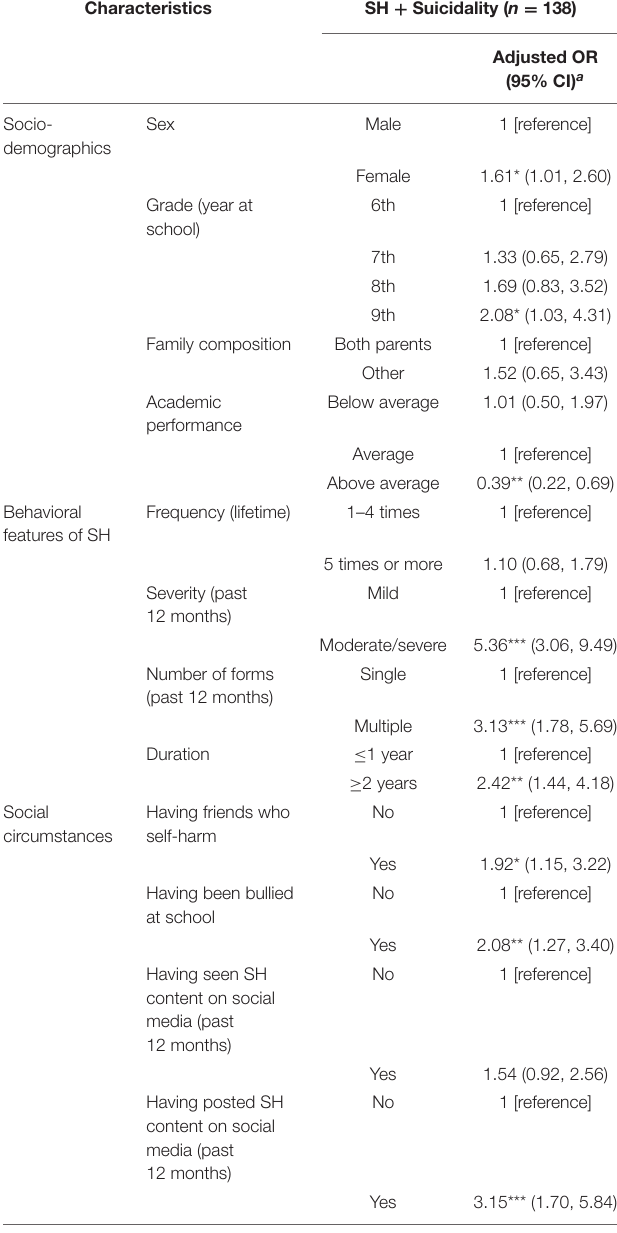
TABLE 2 | Multivariate logistic regression for lifetime suicidality ( n = 902).